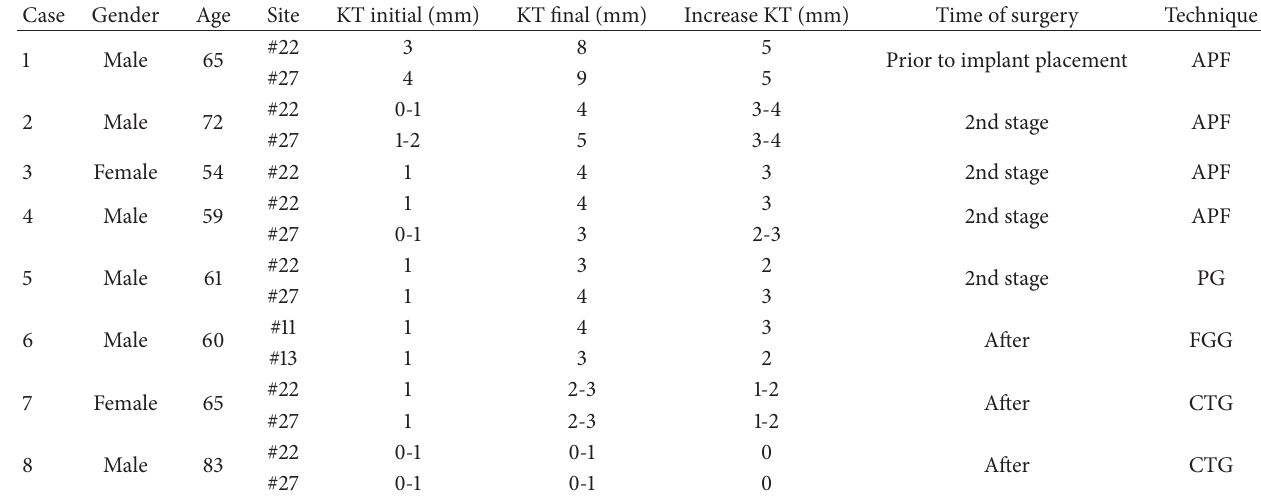
Table 1: Gain in keratinized tissue three months after surgical